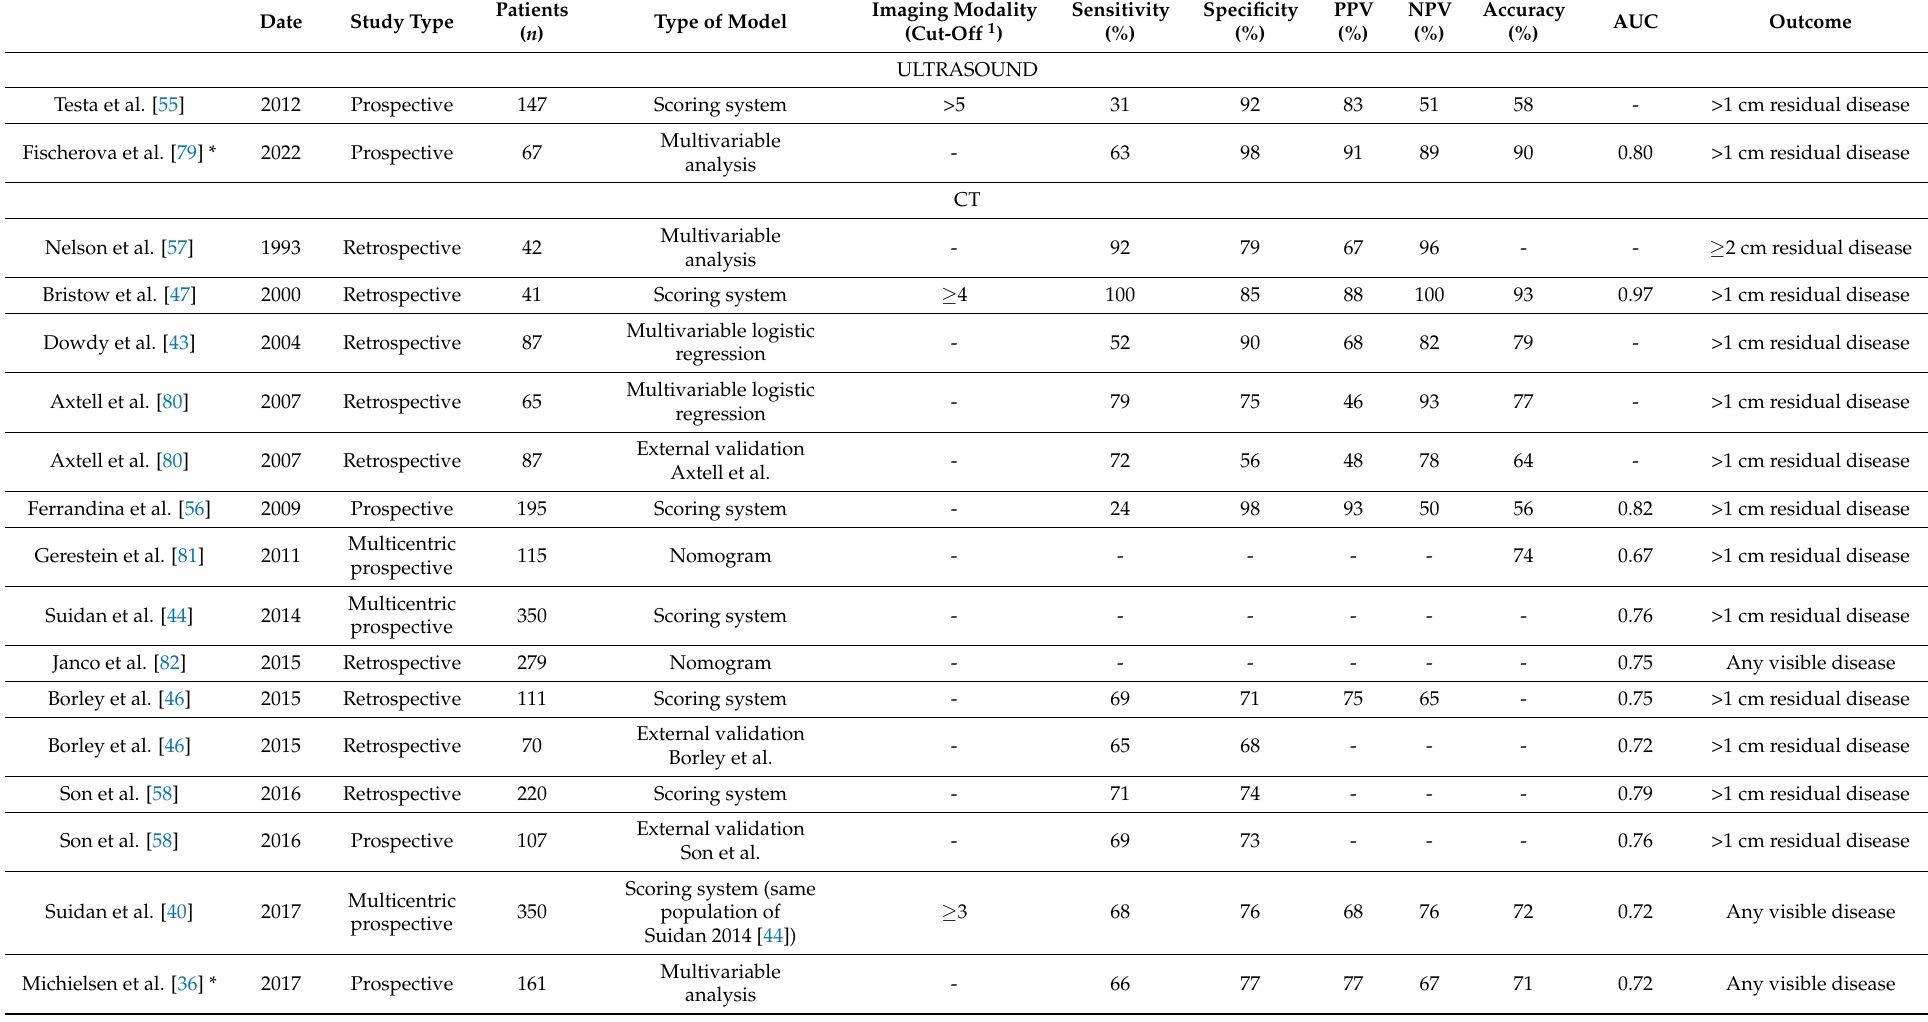
Table 2. Prediction of non-resectability based on preoperative imaging methods and